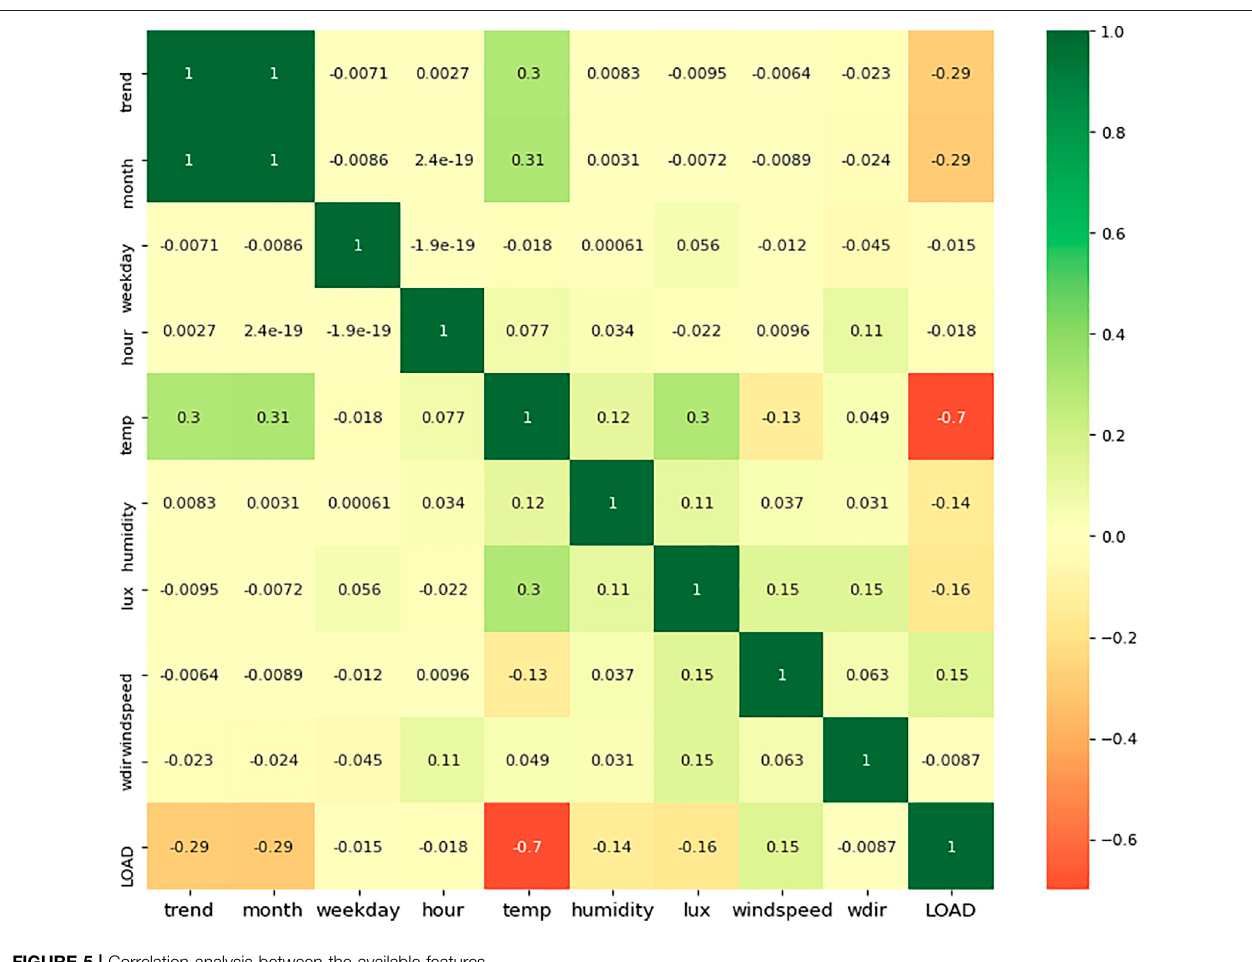
FIGURE 5 | Correlation analysis between the available features.